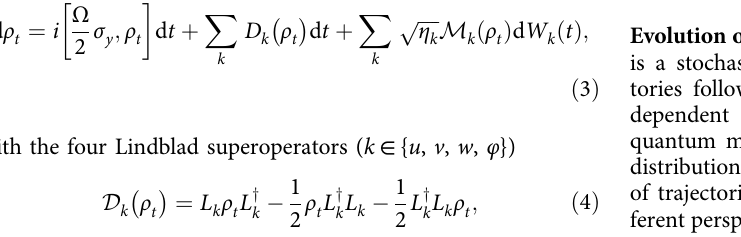
Fig. 2 Direct averaging of the three measurement records. a Dots: rescaled average of the measurement records ~ u ð t Þ = u ð t Þ = ffiffiffiffiffiffiffiffiffiffiffiffi p Γ 2 η for 1.5×10 6 realizations of an experiment where the qubit starts in g j i at time 0 and is driven so that it rotates at a Rabi frequency and ~ w ð t Þ = w ð t Þ = d d Ω /2 π = (2 μ s) − 1 around σ y and endures a measurement induced dephasing rate and z ( t ) from the master equation (Eq. (3) with η i = 0). b Same fi gure in the Zeno regime with a drive such that Ω /2 π = (16 μ s) − 1 and Γ d = (0.9 μ s) −